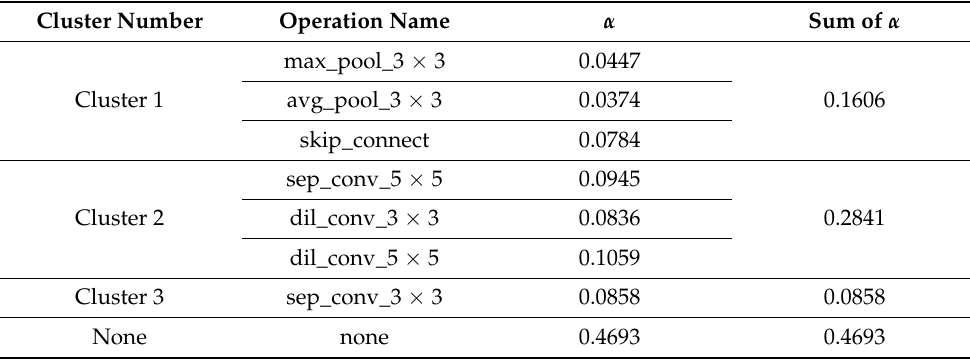
Table 1. Cluster and weight for the seventh mixed operation after stage 1.